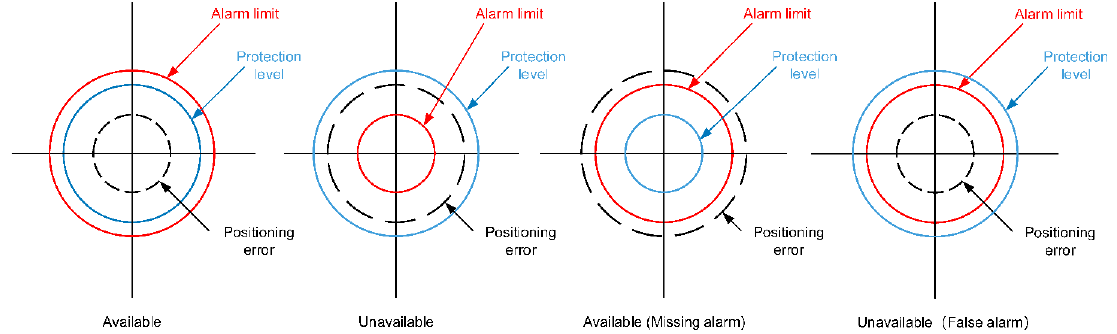
Figure 5. Concept of service availability.